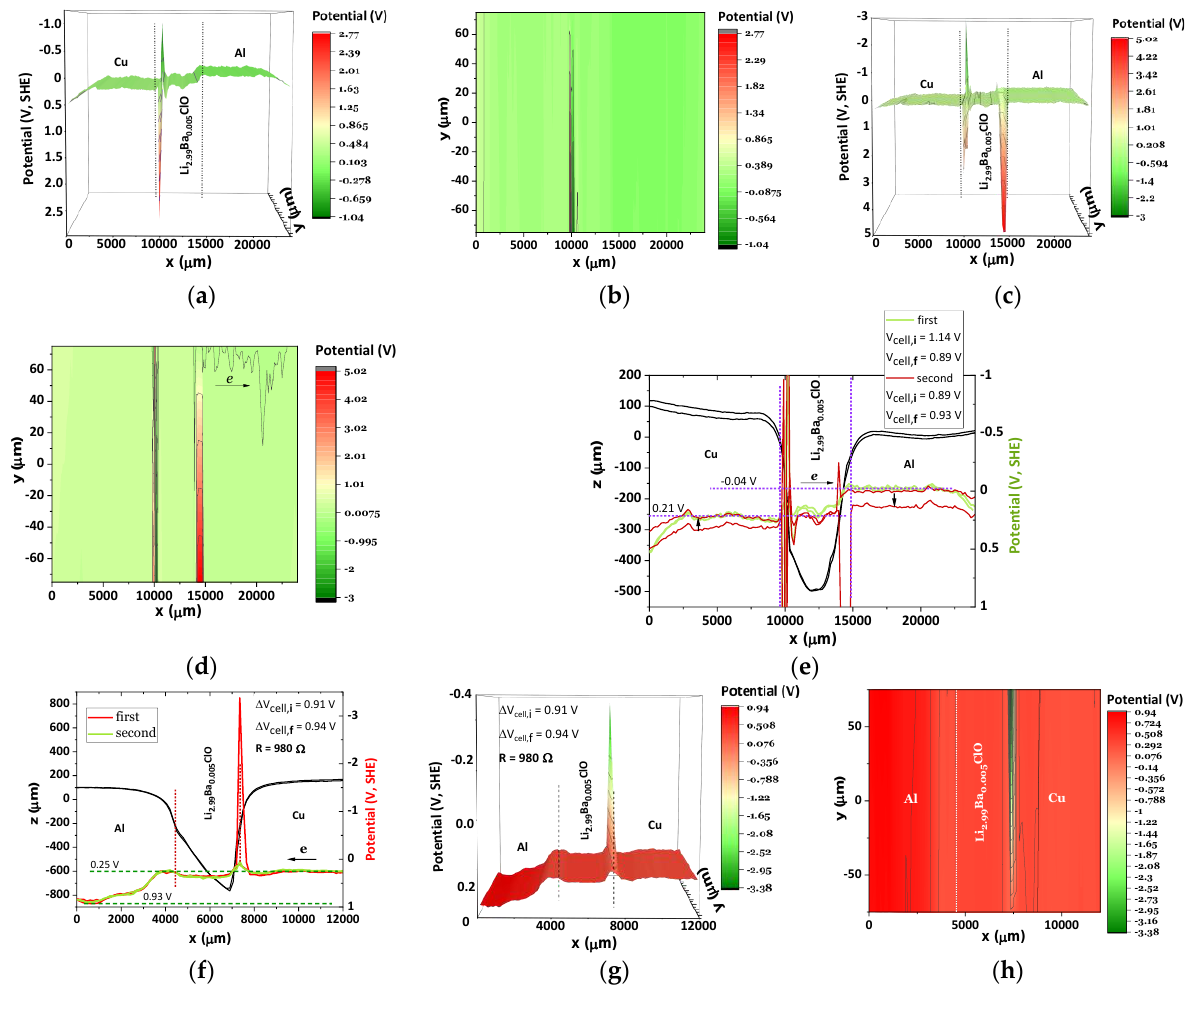
Figure 8. Topography and surface chemical potentials for an Al/Li 2.99 Ba 0.005 ClO (Li + -glass)/Cu cell; ( a – e ) SKP analysis showing evident propagation of the SPP parallel strips (solitons) from the Cu to the Al through the Li + -glass surface; ( f – h ) show different perspectives of the propagation of a plasmon solitons from the Cu electrode at higher potential (Physical scale) to the Al electrode at lower potential through tunneling, diffusion, and drift, when the circuit is closed by a resistor load; the Al is the electrode in contact with the SKP; there is not a considerable variation of the surface chemical potential of the Cu, but the Al dropped down to +0.93 V (SHE).